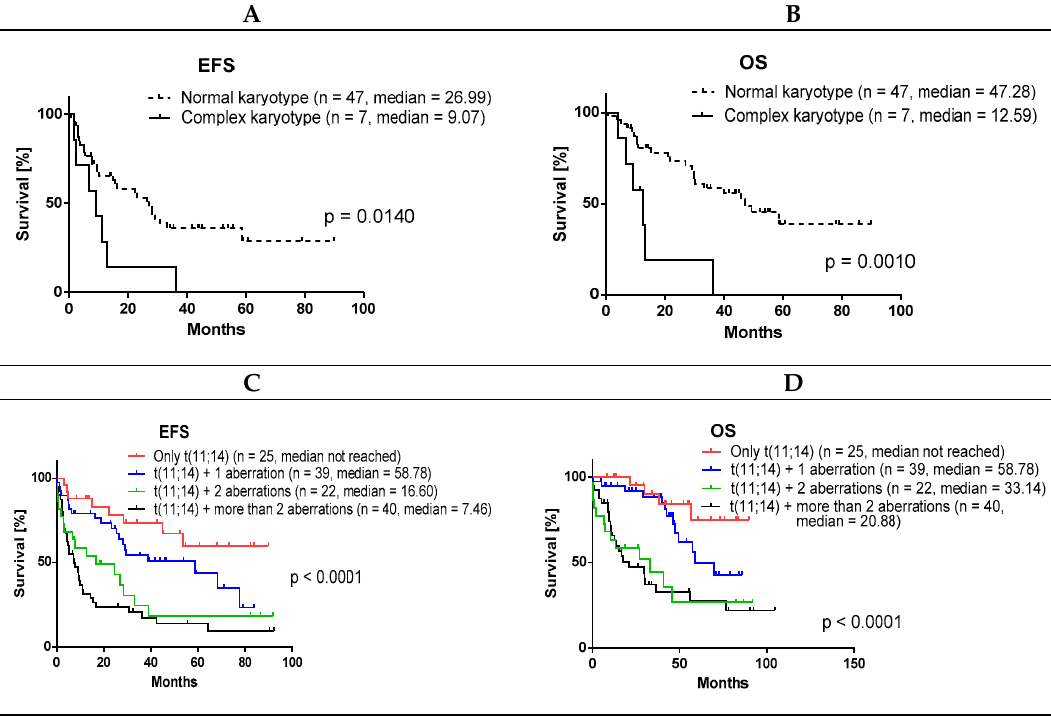
Figure 4. Complex karyotype and total number of gene aberrations correlates with shorter survival.